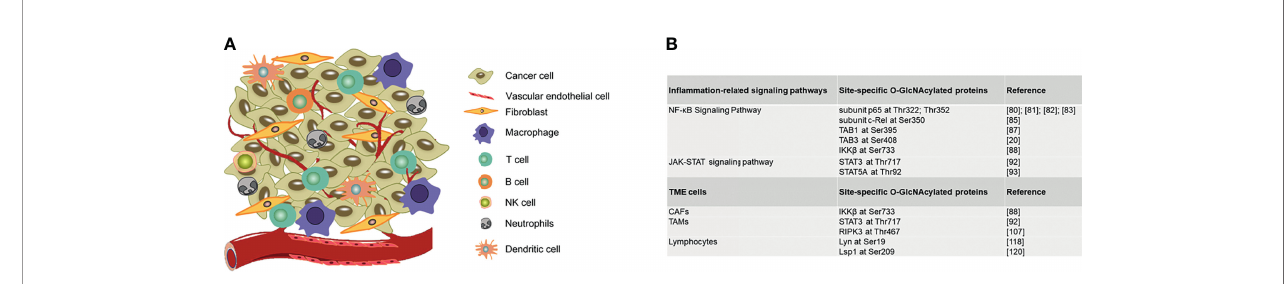
FIGURE 3 | Site-speci fi c O-GlcNAcylation offunctional proteins in regulating in fl ammation-related signaling pathways and stromal cells in TME. (A) Graphic representation of TME cells. (B) Site-speci fi c O-GlcNAcylated proteins in regulating in fl ammation-related signaling pathways and stromal cells in TME. TME, Tumor microenvironment; CAFs, Cancer-associated fi broblast; TAMs, Tumor associated